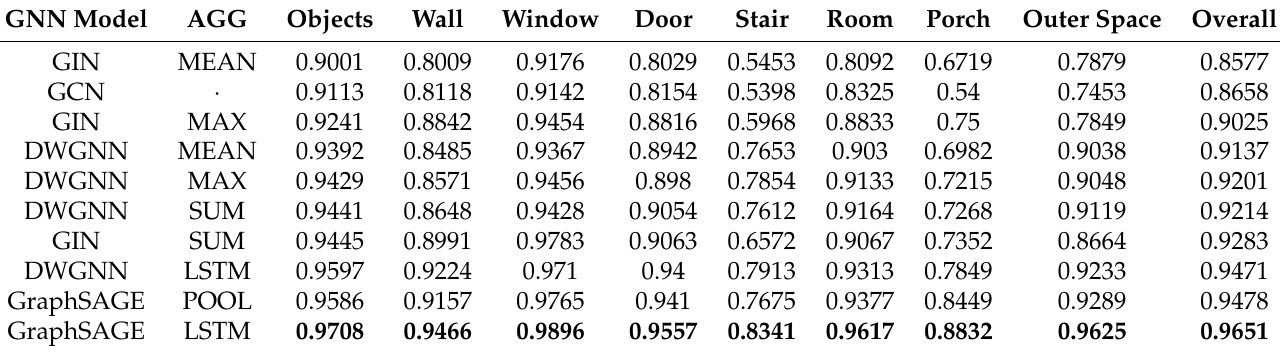
Table 1. Class-wise accuracy comparison by different GNN models on the CubiCasa dataset (micro-averaged F1 score). AGG stands for the AGGREGATE method.